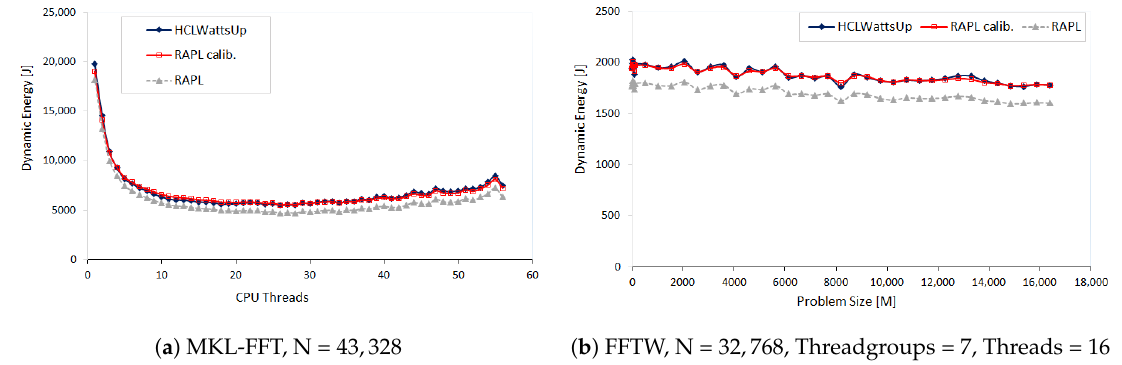
Figure 2. Dynamic energy profiles with Running Average Power Limit (RAPL) and HCLWattsUp on HCLServer03, class A. RAPL calib. means that RAPL readings have been